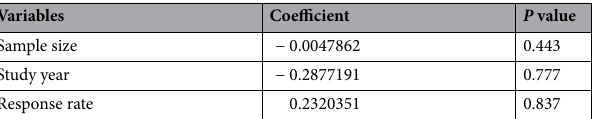
Table 3. Univariate meta-regression analysis to identify factors associated with the heterogeneity of the prevalence of premarital sex in Ethiopia, 2021.